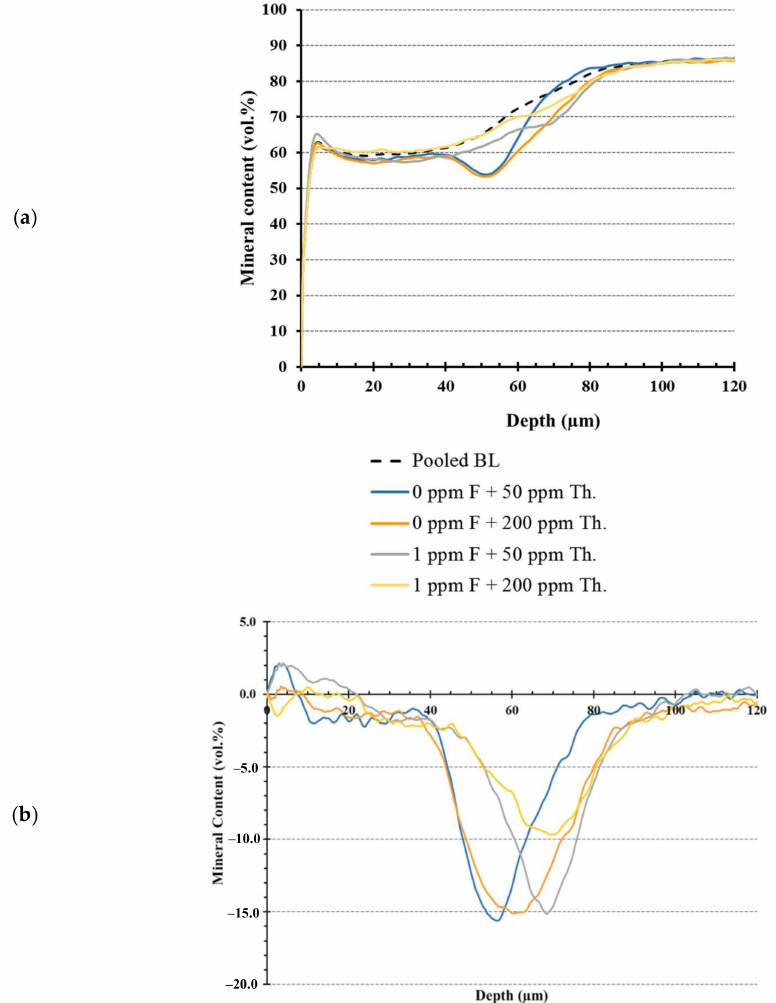
Figure 1. Graphs showing the mineral distribution for the study groups created by averaging values from all specimens in each group: ( a ) overall mineral distribution profiles for pooled spec- imens before secondary demineralization at baseline (dotted black line) compared to individual groups (solid lines) after secondary demineralization protocol and ( b ) changes in mineral content for the four experimental groups after respective secondary demineralization protocol with varying fluoride(F)/theobromine (Th.)